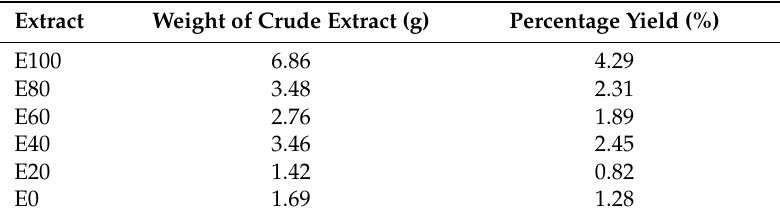
Table 1. Weight and percentage yield of crude extract of D. sanderiana